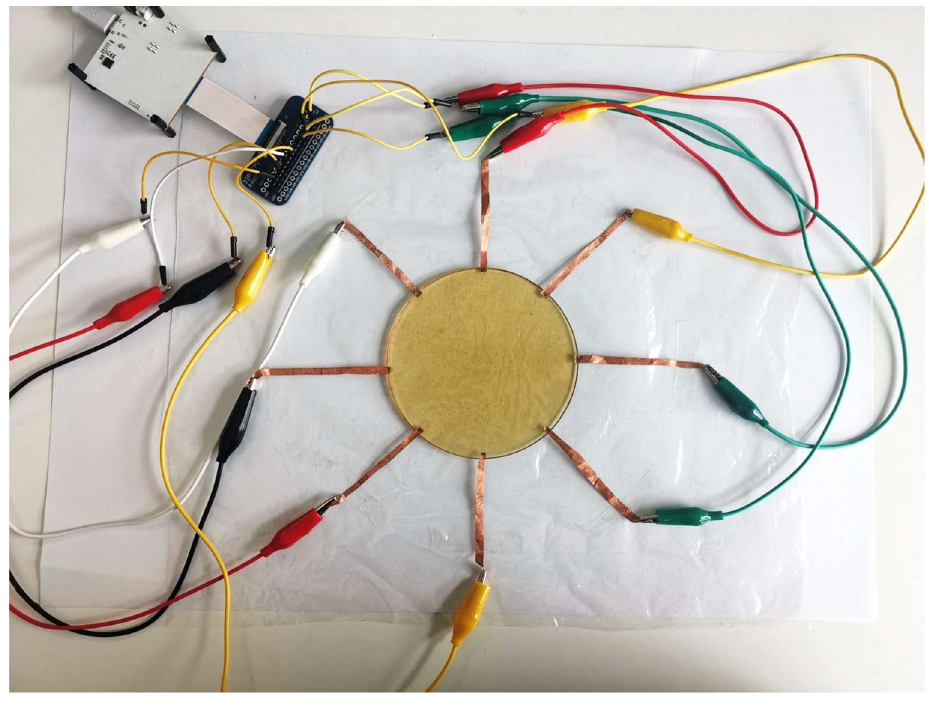
Figure 4. The sensor is connected to a data acquisition device to allow data collection.